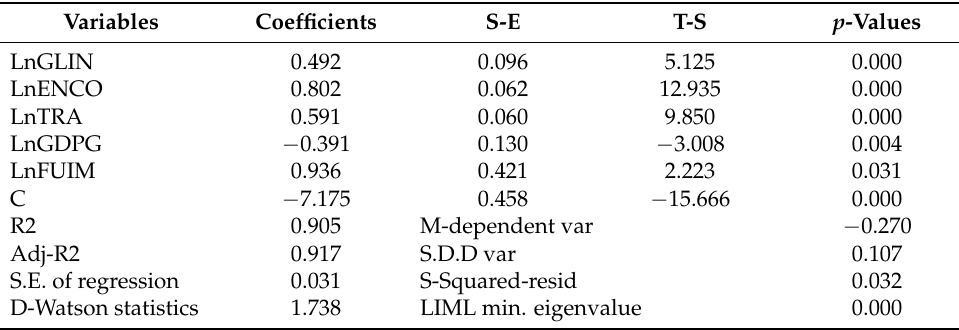
Table 6. Outcomes of limited information maximum likelihood and K-class.